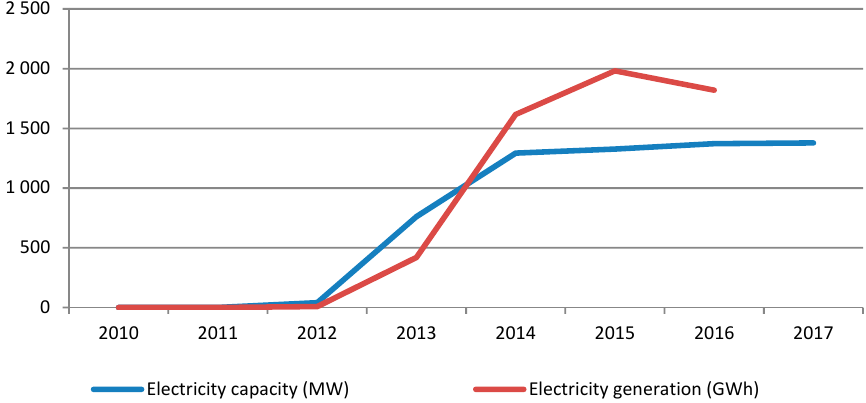
Figure 14. Main photovoltaic indicators evolution between 2010 and 2016, Source: Own research based on Eurostat and IRENA data [32].